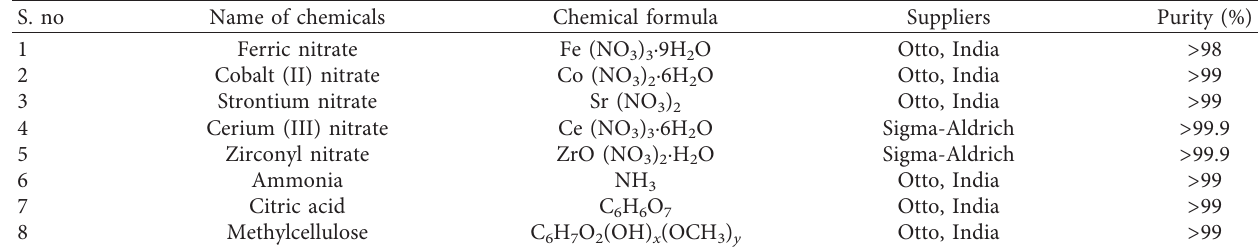
Table 1: Chemicals and ingredients